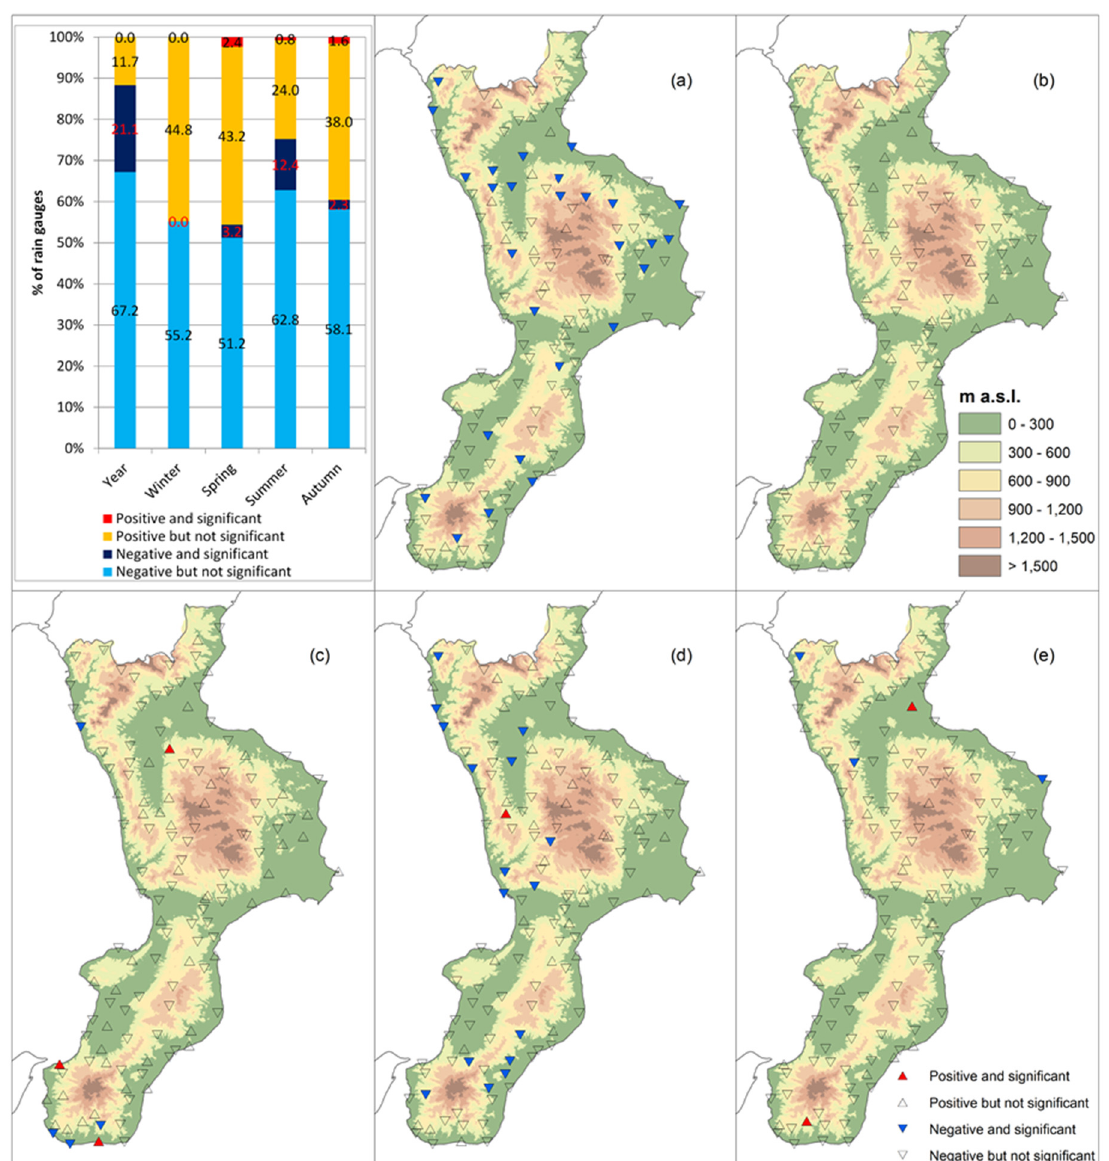
Figure 6. Summary and spatial distribution of the trend analysis on dry spell durations at ( a ) annual and seasonal scale: ( b ) winter; ( c ) spring; ( d ) summer and ( e )